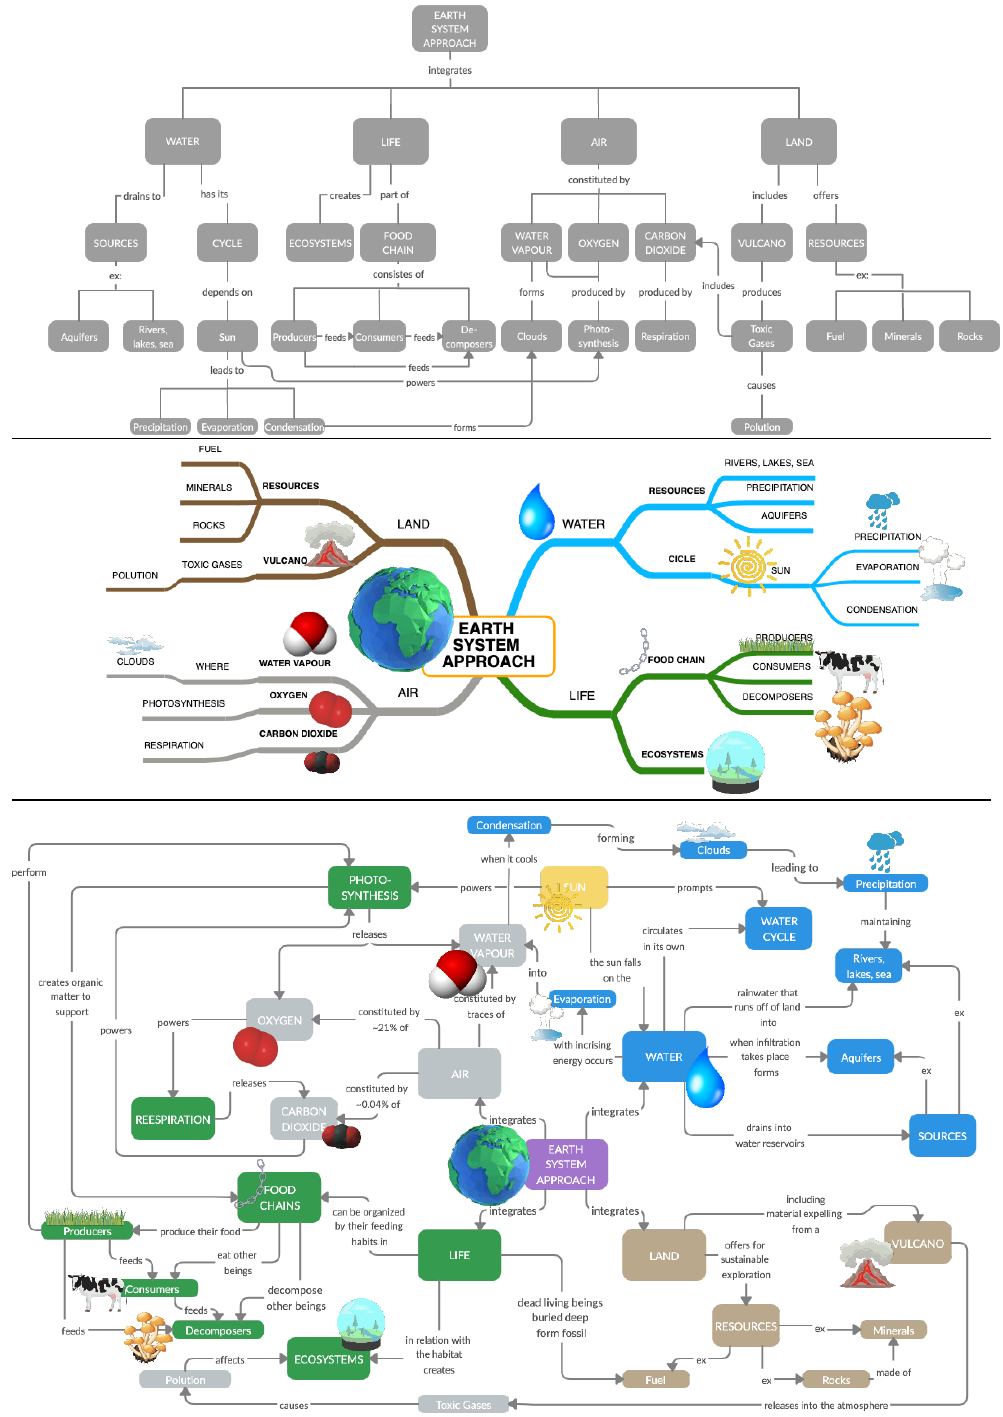
Figure 1 . Example of a Novakian standard concept mapping ( upper ), mind mapping ( middle ), and improved method for concept mapping ( lower ), regarding the same ESA-related concepts.